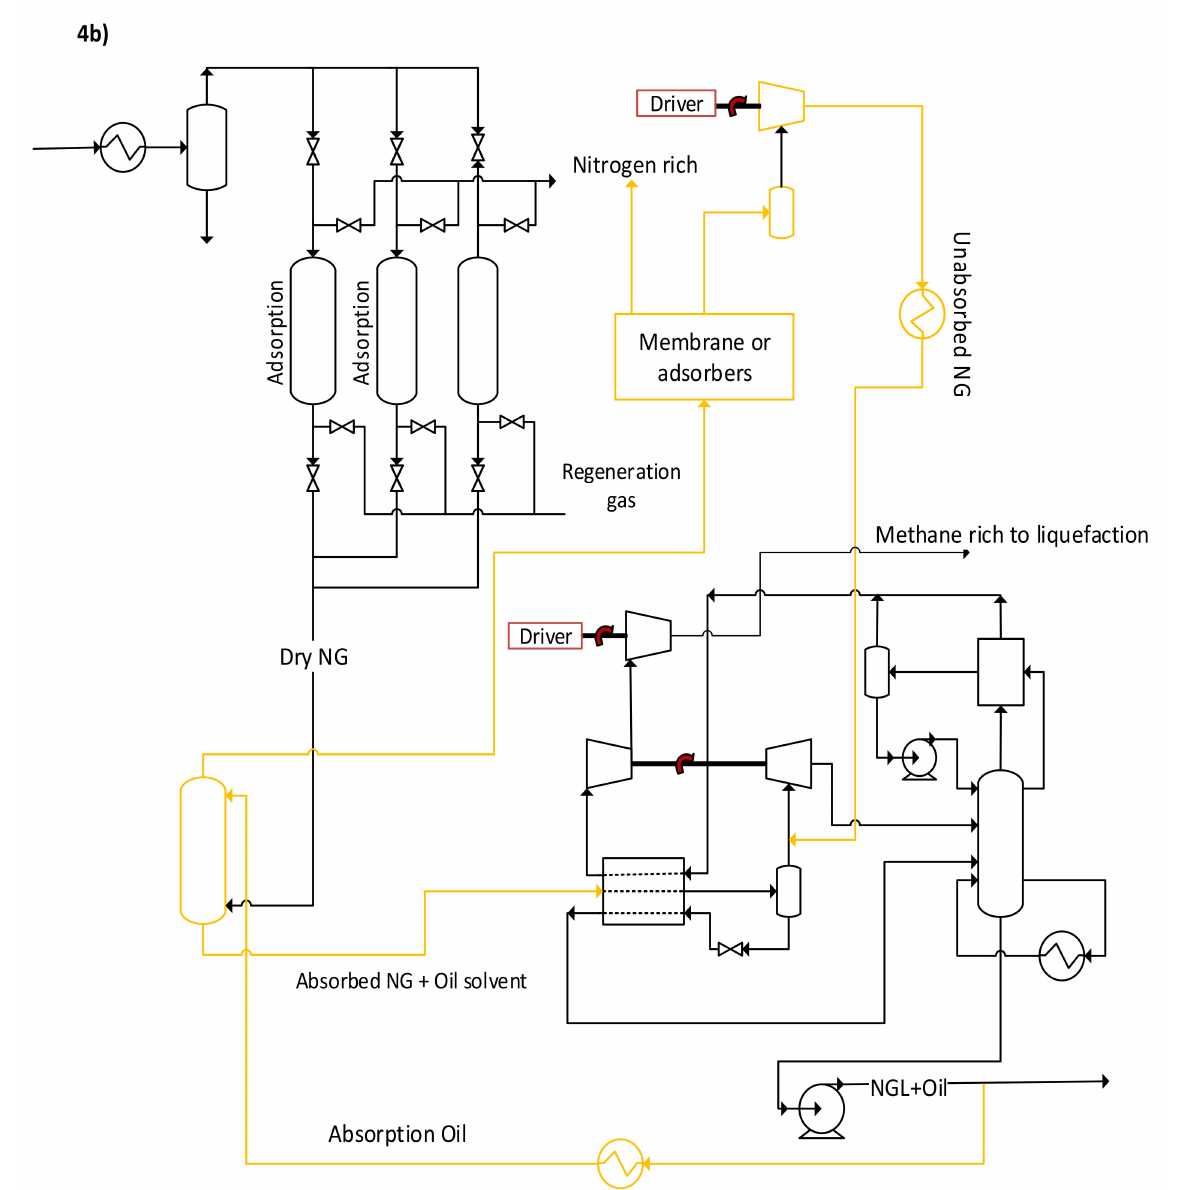
Figure 4. ( a ) Hybrid absorption and membrane upfront N 2 removal unit, and ( b ) integration of hybrid the upfront N 2 removal unit in the existing NGL recovery process (Orange